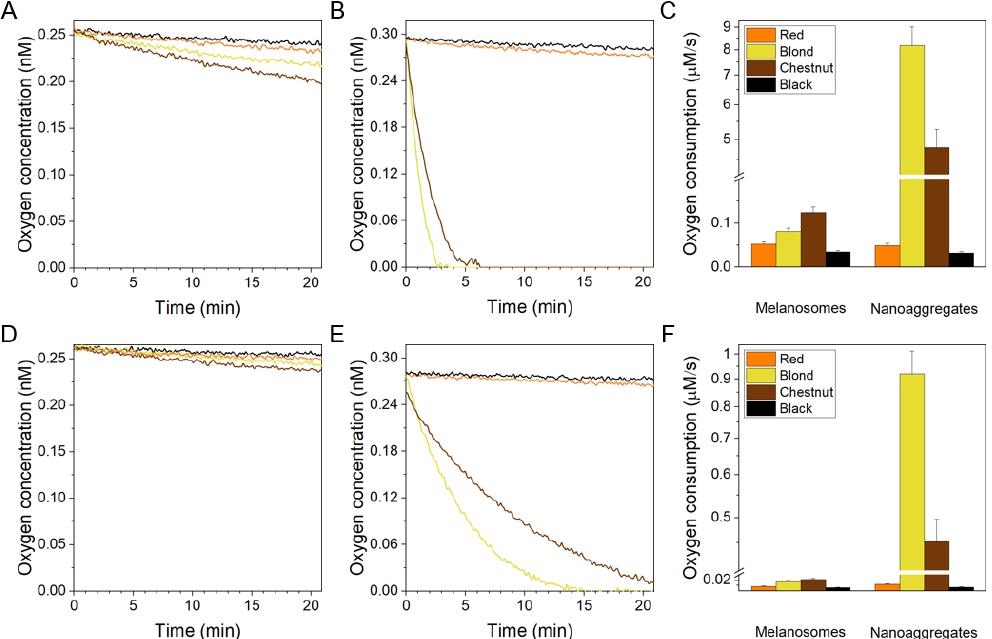
Figure 5. Photoinduced consumption of oxygen by natural melanin pigments under 365 nm ( A – C ) and 445 nm ( D – F ) irradiation. ( A , D ) show results for melanosomes whereas ( B , E ) show results for melanin nanoaggregates. ( C , F ) show histograms of initial intensities of oxygen consumption for both melanosomes and nanoaggregates of different hair melanins. Colors lines indicate the following samples: orange (red hair), yellow (blond hair), brown (chestnut hair), and black (black hair).